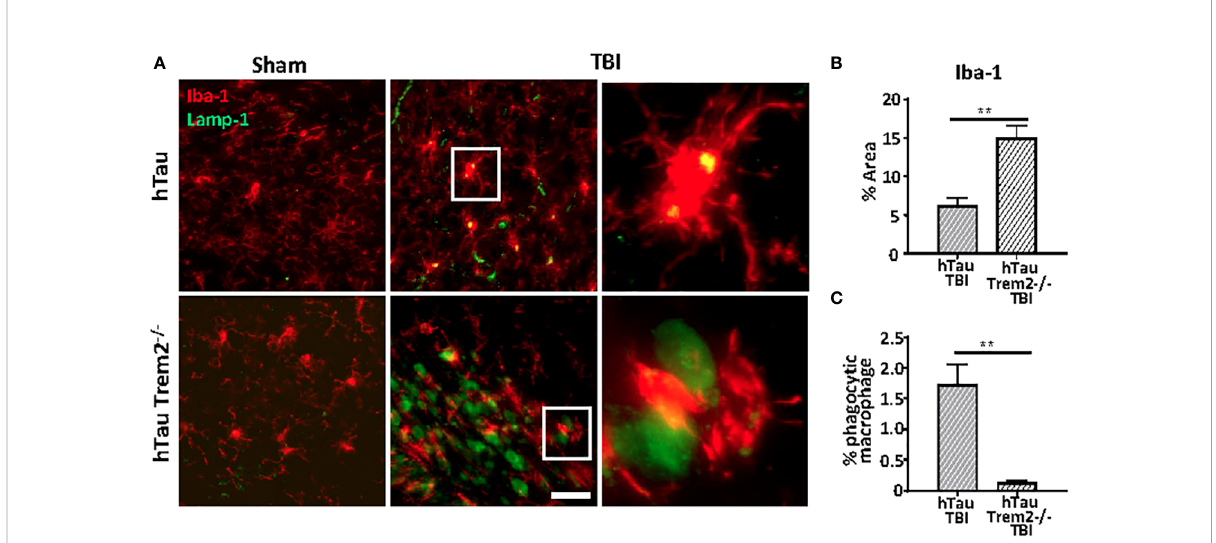
FIGURE 6 The phagocytic function was impaired in hTau; Trem2 -/- TBI mice compared with hTau TBI mice in the chronic phase. (A) Representative images of Iba-1 (red) and Lamp-1 (green) in sham (far left column) and TBI (middle column). Enlarged images of the TBI group are in the far-right column. Although the number of Iba-1 positive microglia/macrophages was increased in hTau; Trem2 -/- mice (B) , the percent of Iba-1 + cells that contained Lamp-1 + elements was signi fi cantly low in hTau; Trem2 -/- TBI mice relative to hTau TBI controls (C) . All experiments used n = 6 (equal males and females) mice per group unless otherwise noted. At least two independent experiments were performed for each analysis. The scale bar represents 20 m m. Error bars indicate SEM; ** p